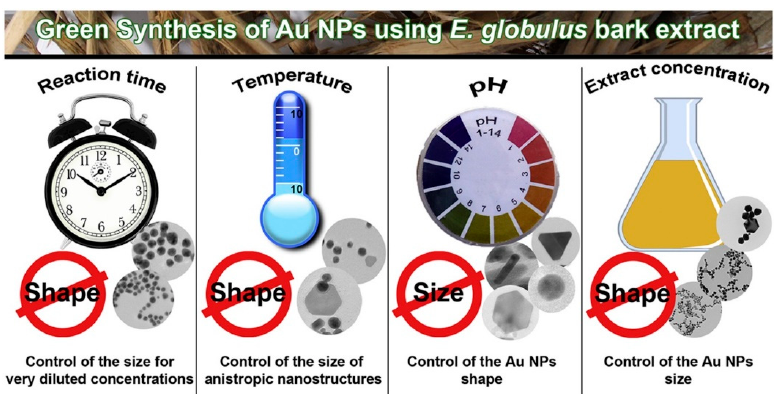
Figure 12. Effects of reaction time, temperature, pH, and extract concentration on the biosynthesis of Au NPs. Reprinted/adapted with permission from Ref. [74]. Copyright 2017, Elsevier. Table 2. Comparison of size and shape in the biological synthesis of Au/Ag NPs.